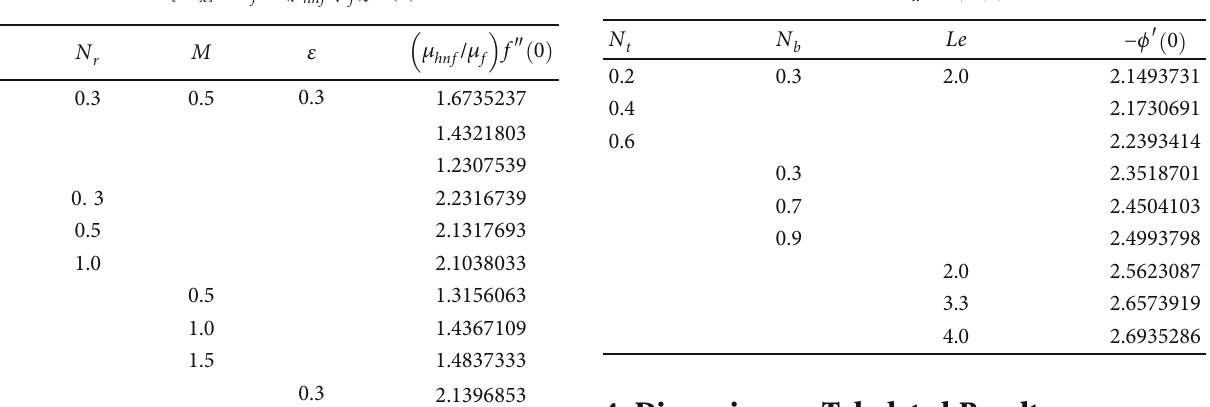
factors on skin friction ½ Re